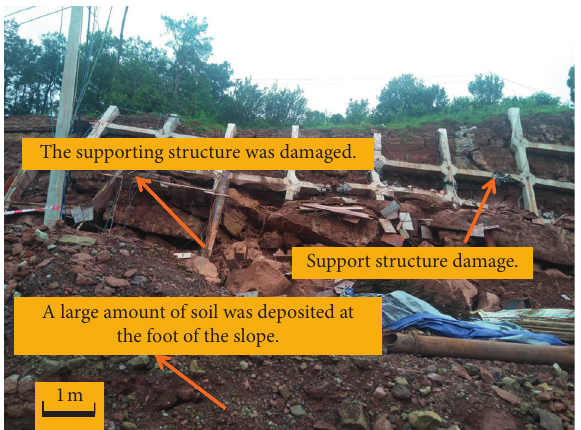
Figure 3: Failure diagram of frame anchor cable on landslide front